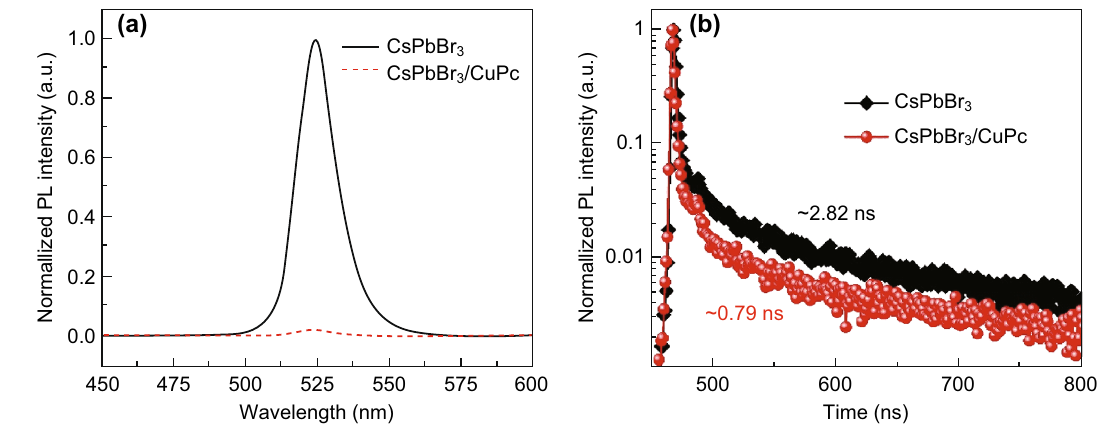
Fig. 3 Steady-state a and time-resolved b PL spectra of the CsPbBr 3 and CsPbBr 3 /CuPc